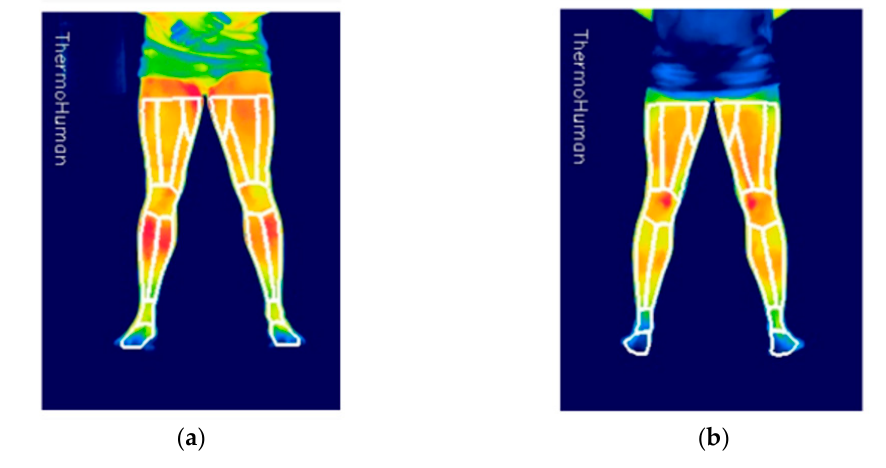
Figure 3. Thermographic imaging. ( a ) Front and ( b ) back.